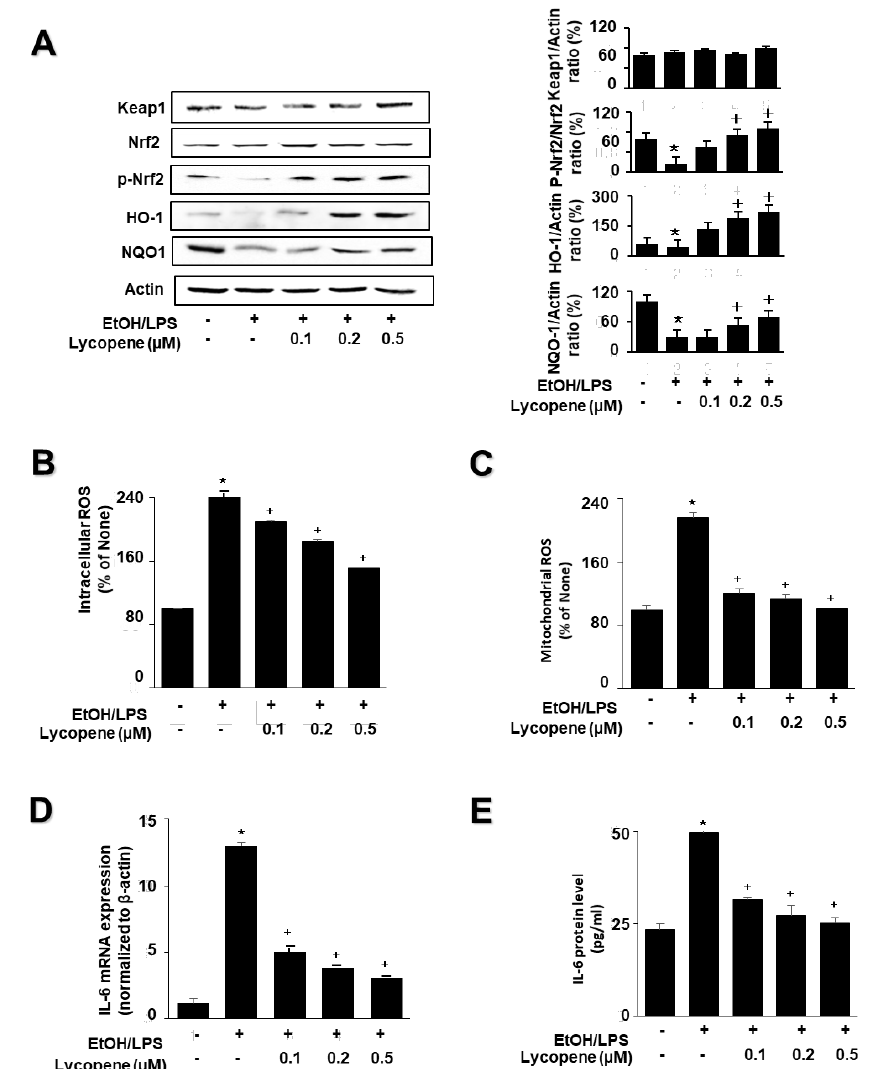
Figure 3. Effect of lycopene on ethanol (EtOH)/lipopolysaccharides (LPS)-induced changes in the levels of phosphorylated Nrf2, HO-1, NQO1, ROS, and IL-6 in AR42J cells. Cells (1 × 10 6 /10 mL/dish or 2 × 10 5 /2 mL/well) were pretreated with the indicated concentrations of lycopene for 1 h, and subsequently stimulated with EtOH (at a final concentration of 250 mM)/LPS (10 µ g/mL) for 30 min. ( A ) Protein levels were determined by western blot analysis of whole-cell extracts, using actin as the loading control ( left panel ). The densitometry analysis-derived ratios of Keap1/actin, p-Nrf2/Nrf2, HO-1/actin, and NQO1/actin in whole-cell extracts represent mean ± S.E. from three immunoblots. The ratio of control cells (cells without EtOH/LPS stimulation and without any treatment) was set at 100% ( right panel ). ( B ) Intracellular ROS levels were determined by DCF fluorescence. ( C ) Mitochondrial ROS levels were measured by determining the level of fluorescent MitoSOX. The value for ROS levels in control cells (cells in the absence of EtOH/LPS and without lycopene treatment) was set at 100%. ( D ) mRNA expression level of IL-6 was determined by real-time polymerase chain reaction and normalized to that of β -actin. The IL-6 mRNA level in control cells (cells in the absence of EtOH/LPS and without lycopene treatment) was set as 1. ( E ) Levels of IL-6 in the medium were measured using enzyme-linked immunosorbent assay. Data are expressed as the mean ± SE ( n = 12 in each group). * p < 0.05 vs. control cells (cells without EtOH/LPS stimulation and without lycopene treatment). The cells incubated with tetrahydrofuran (THF, 0.01%) alone served as a vehicle control. For each experiment, lycopene-untreated cells received a vehicle THF (0.01%) alone instead of lycopene. +,